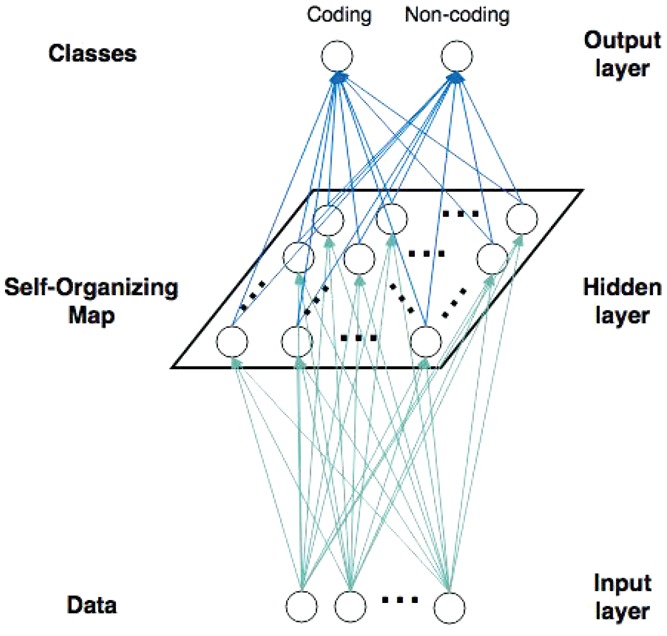
IRSOM architecture